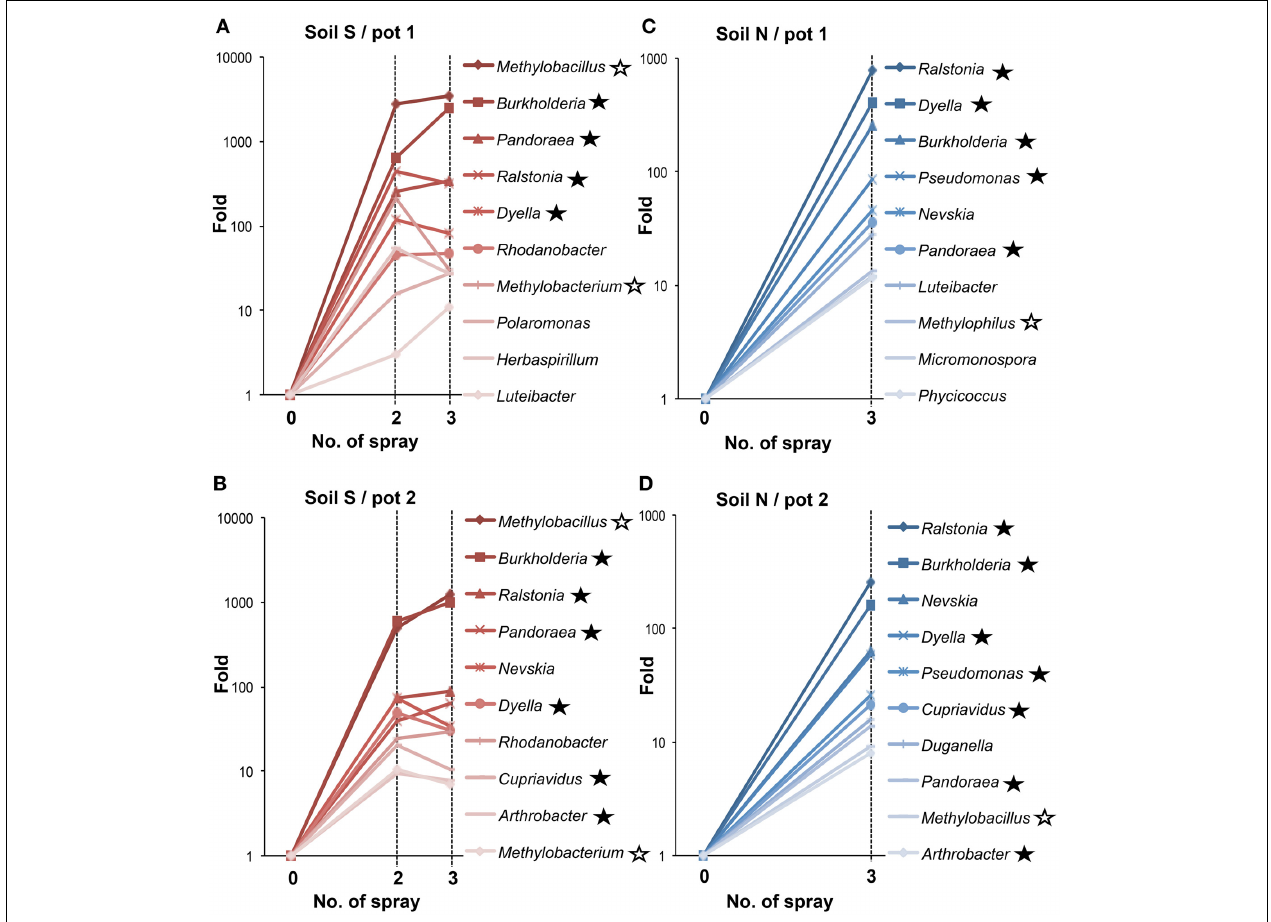
FIGURE 4 | Temporal changes of relative proportions of bacterial genera during MEP-spraying. (A,B) Soil S; (C,D) soil N. Relative proportions of bacterial genera were estimated based on the read numbers of deep sequencing of 16S rRNA sequences. Closed asterisks indicate the genera, which have been reported to degrade MEP (Tago